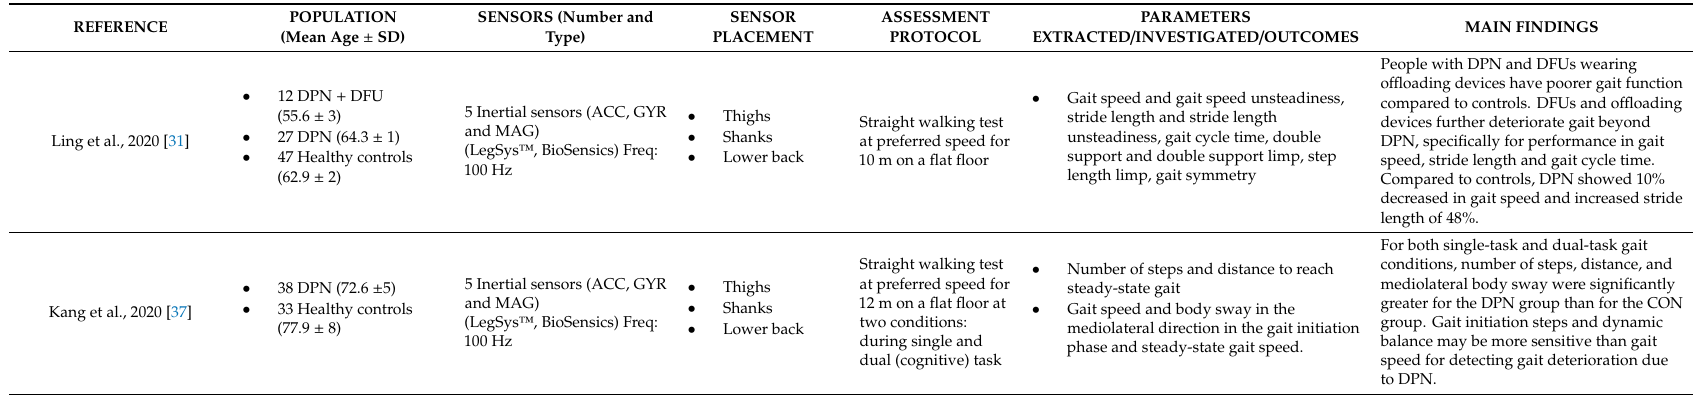
Table 2. Summary of the major characteristics of the research design, analyses, and outcomes for the studies on PNP that met the inclusion